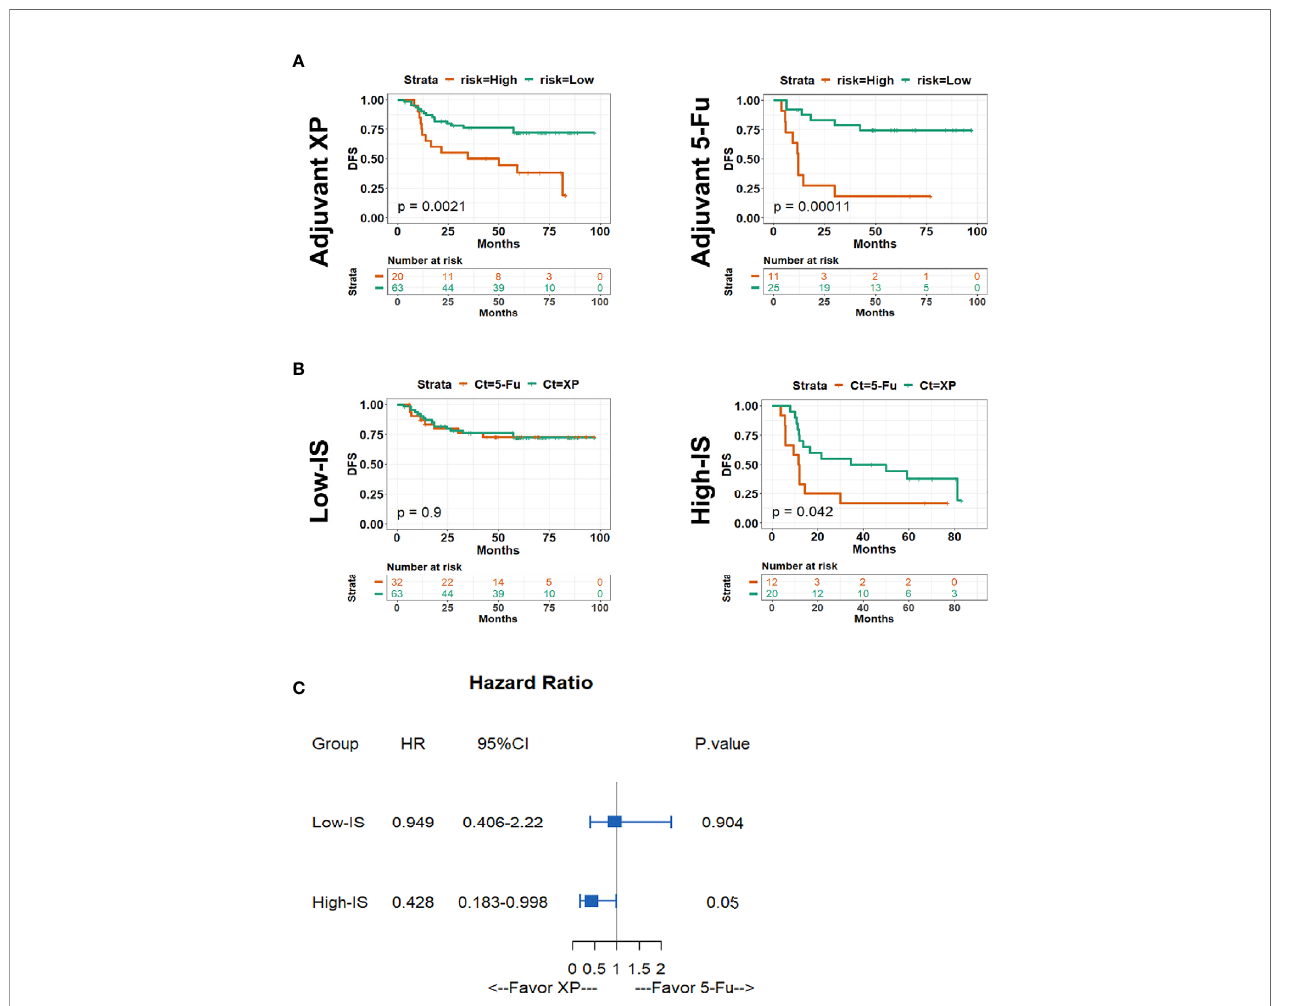
FIGURE 6 | Kaplan-Meier survival analysis of DFS strati fi ed by types of adjuvant chemotherapy among stages II and III patients. (A) Kaplan-Meier curves of patients in XP group (left panel) and 5-Fu group (right panel) strati fi ed by IS; (B) Kaplan-Meier curves of patients in Low-IS group (left panel) and high-IS group (right panel) strati fi ed by chemotherapy regimen; (C) Forest plot describing the bene fi t of chemotherapy regimen in different IS groups. IS , immunoscore; XP , Xeloda plus cisplatin; 5-Fu 5- fl